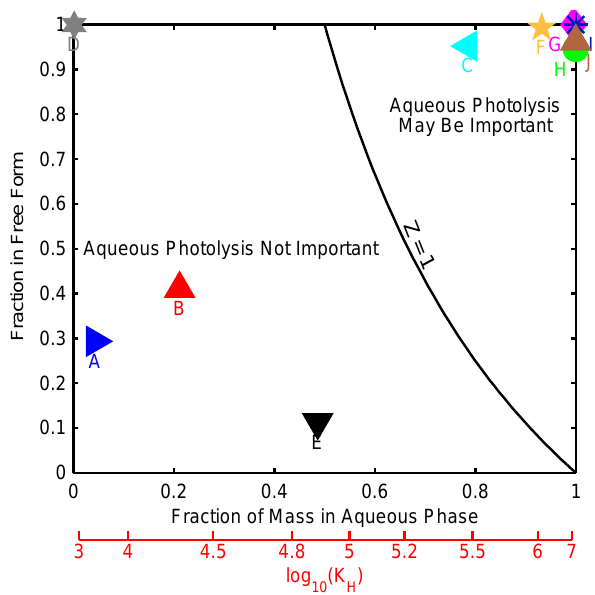
Fig. 3. Hydration equilibrium vs. the fraction of total mass resid- ing in the aqueous phase at equilibrium for photolabile compounds formed from isoprene (Fang et al., 2012) and limonene (Jaoui et al., 2006) photooxidation. Liquid water content is 0.5gm − 3 . (A) methylglyoxal, (B) 4-hydroxybut-3-en-2-one (assumed to be all 3-oxobutanal after keto-enol equilibrium (Cederstav and Novak, 1994)), (C) pyruvic acid, (D) 1-hydroxy-3-methyl-but-3-en-2-one, (E) 2-methyl-2-oxidanyl-propanedial, (F) 4-hydroxy-3-methyl-but- 2-enal, (G) levulinic acid, (H) 3,6-oxoheptanoic acid, (I) ketonor- limonic acid, (J) ketolimonaldehyde. Structures, effective Henry’s law constants, and hydration equilibrium constants are presented in Tables S6 and